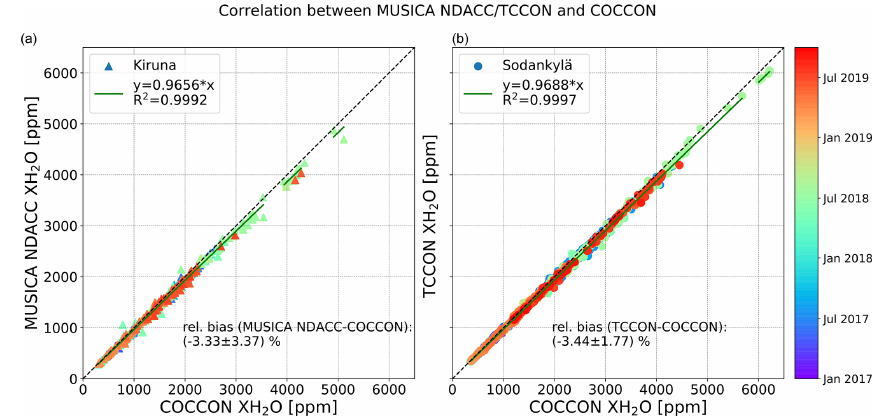
Figure 2. (a) The correlation of COCCON XH 2 O and coincident MUSICA NDACC retrievals for Kiruna, and (b) the correlation of COC- CON and coincident TCCON retrievals for Sodankylä. The solid green and dashed lines denote the linear fit and one-to-one lines, respectively. The color code (from purple to red) represents the order of the measurement time from January 2017 to October 2019.